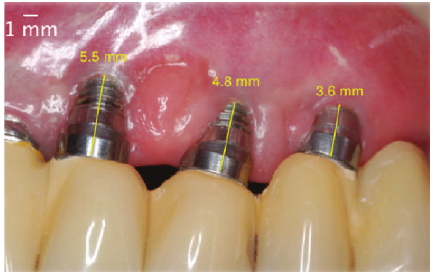
Figure 1: Initial appearance. Note exposure of threads and the absence of keratinized mucosa.